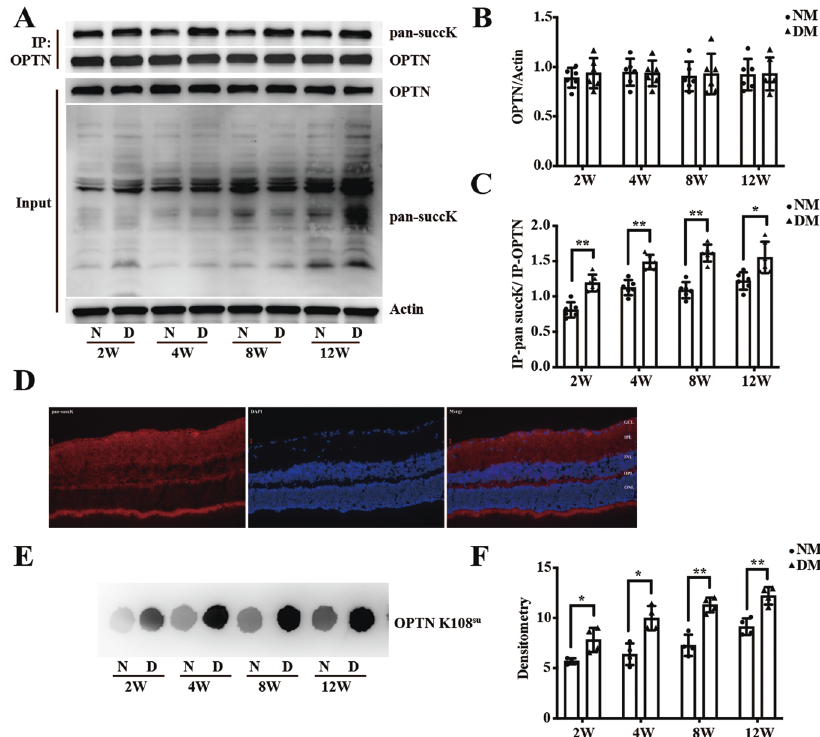
Fig. 3 The expression of OPTN K108 su in the rat retina. A Endogenous OPTN was succinylated in rat retinas. OPTN was immunoprecipitated from whole retinal proteins using an anti-OPTN antibody, followed by western blotting with an anti-pan-succK antibody. Global protein succinylation and OPTN expression in whole retinal lysate were detected by western blotting. Bar graph showing the relative expression of OPTN protein (normalized to β -actin) in whole retinal lysate ( B ) and the pan-succinylation level of IP-OPTN (normalized to IP-OPTN, C ). D Immuno fl uorescent staining of succinylation proteins in the retina. E , F Endogenous OPTN K108 su was succinylated in rat retinas. Succinylation of the OPTN K108 site was detected by dot blotting with a custom-made site-speci fi c anti-succK108-OPTN antibody. Representative four immunoblots ( D ) and quantitative data ( E ) for each group are provided ( n = 4). The data are shown as the mean ± SD ( n = 6). * p < 0.05. ** p < 0.01. OPTN K108 su succinylation of the OPTN lysine 108 site, IP immunoprecipitation, NM normal glucose group, DM diabetes mellitus